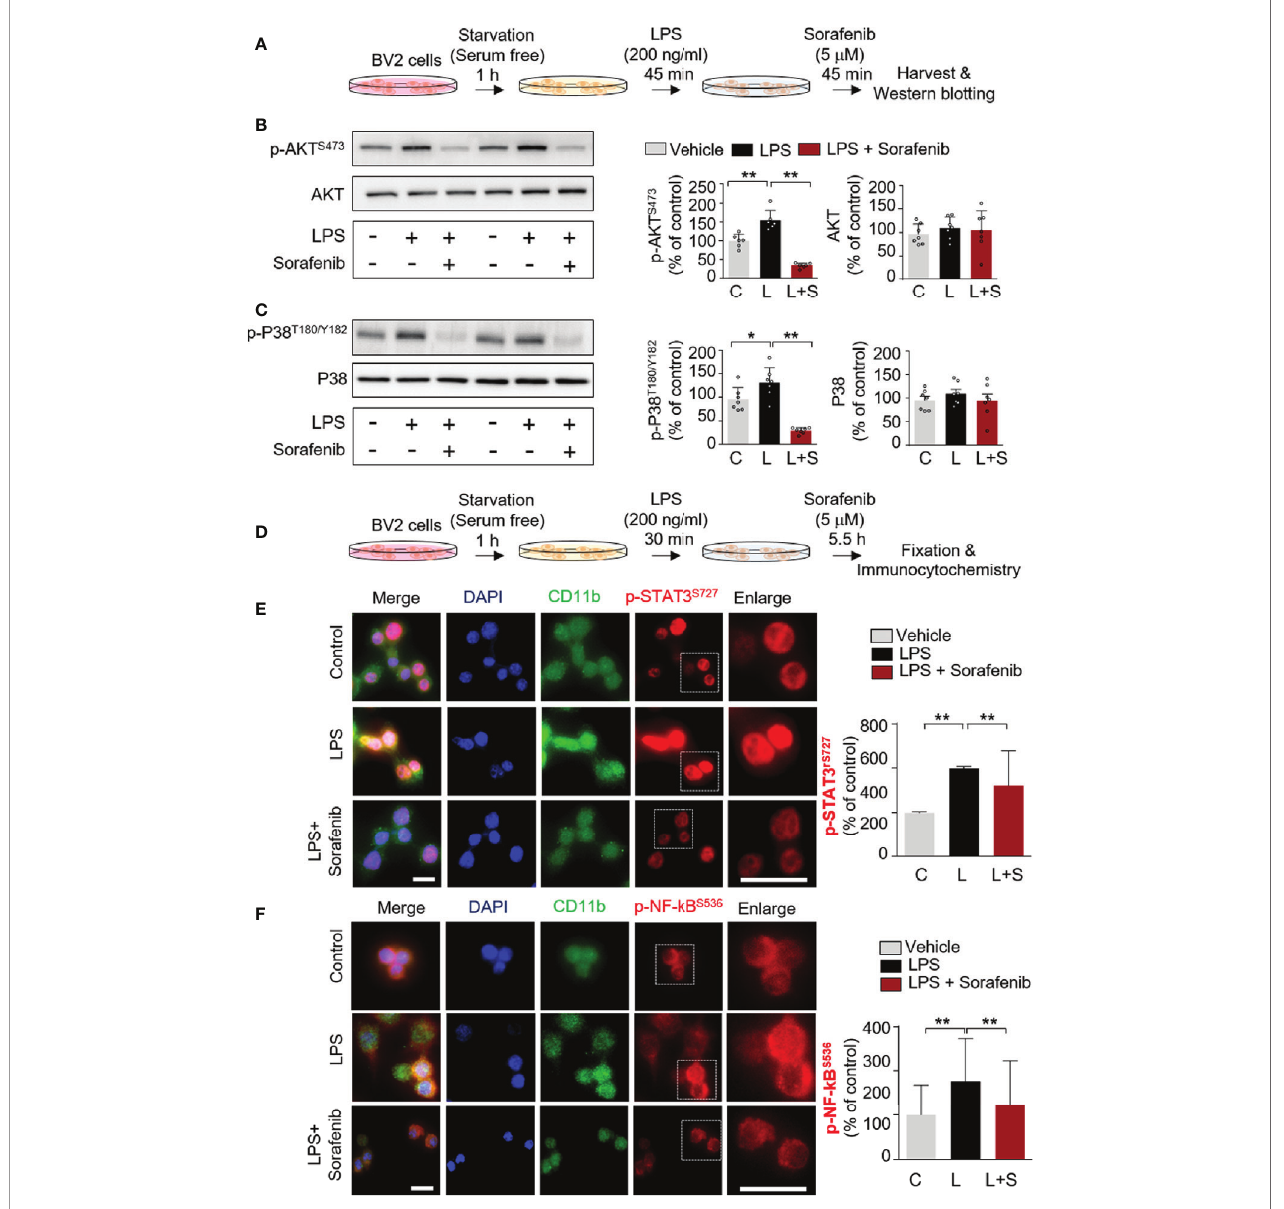
FIGURE 2 | Sorafenib downregulates the LPS-induced increases in p-AKT/p-P38 and nuclear p-STAT3/p-NF-kB levels. (A) Scheme for sequential treatment of BV2 cells with LPS and sorafenib. (B, C) Western blotting analysis of BV2 cells treated as described in (A) with anti-p-AKT S473 , anti-AKT, anti-p-P38 T180/Y182 , and anti- P38 antibodies (n=6/group). (D) Scheme for sequential treatment of BV2 cells with LPS and sorafenib. (E, F) Immunocytochemistry analysis of BV2 cells treated as described in (D) with anti-CD11b and anti-p-STAT3 S727 antibodies (number of cells (n); Vehicle, n=428; LPS, n=357; LPS+sorafenib, n=361) or anti-CD11b and anti- p-NF-kB Ser536 antibodies (Vehicle, n=461; LPS, n=584; LPS+sorafenib, n=416). *p < 0.05, **p < 0.01, Scale bar = 20 m